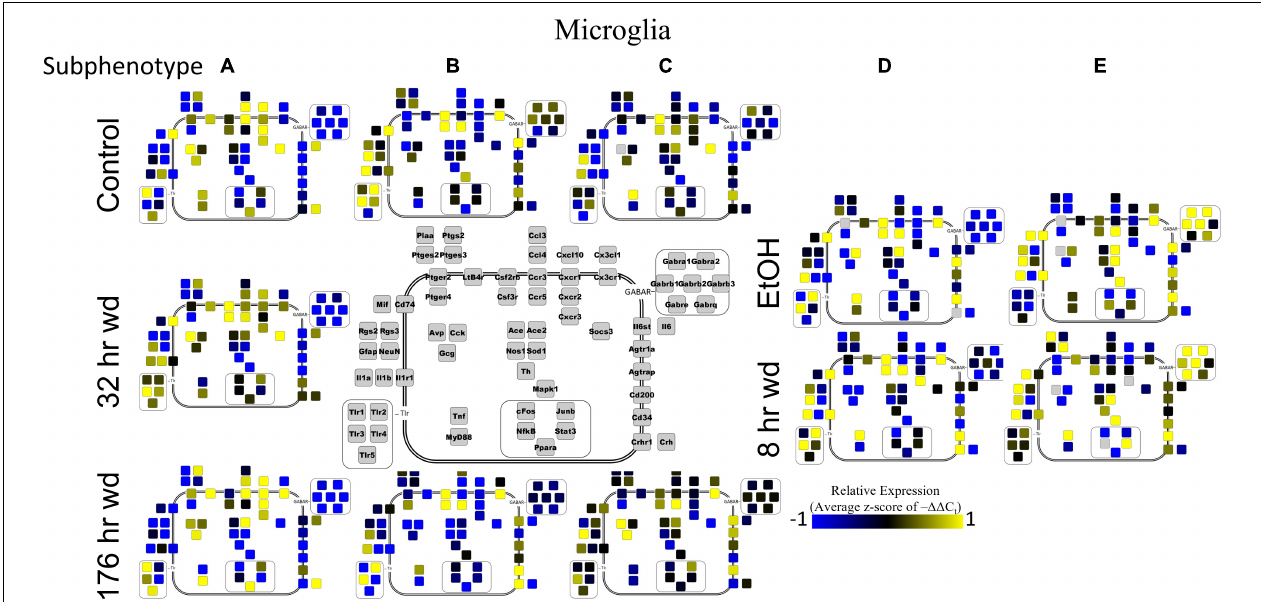
FIGURE 8 | Subphenotype Gene Expression in Norepinephrine Neuron Enriched Samples. Cellular diagrams display boxes representing relative gene expression (average z-score of – (cid:49)(cid:49) C t values) of subphenotypes shown in prior heatmaps. Legend with gray boxes in center of figure labels which boxes correspond to which gene. Box color represents expression (blue is low expression and yellow is high expression). The location of the box represents the localization or function of the protein product from that gene